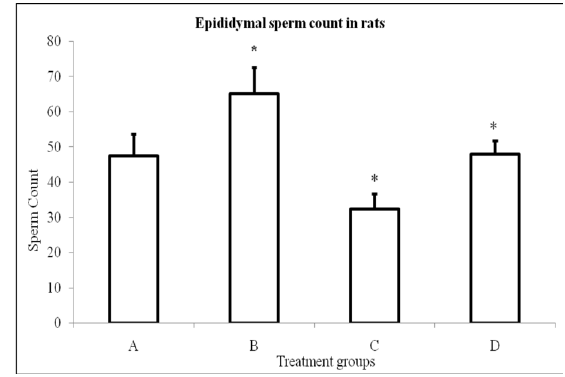
*p < 0.05 as compared to group A (control) *p < 0.05 as compared to group D (EL + estradiol) Figure 4 - Epididymal sperm counts in rats treated with EL (B), estradiol (C) and a combination of EL and estradiol (D), compared to the control (A). The values are shown as the mean + standard deviation. Group B shows a marked increase in the spermatogenic cell count compared to the control (group A) and group D (EL + estradiol). The cell count is significantly re- duced in group D (estradiol-treated rats) compared to group A and group